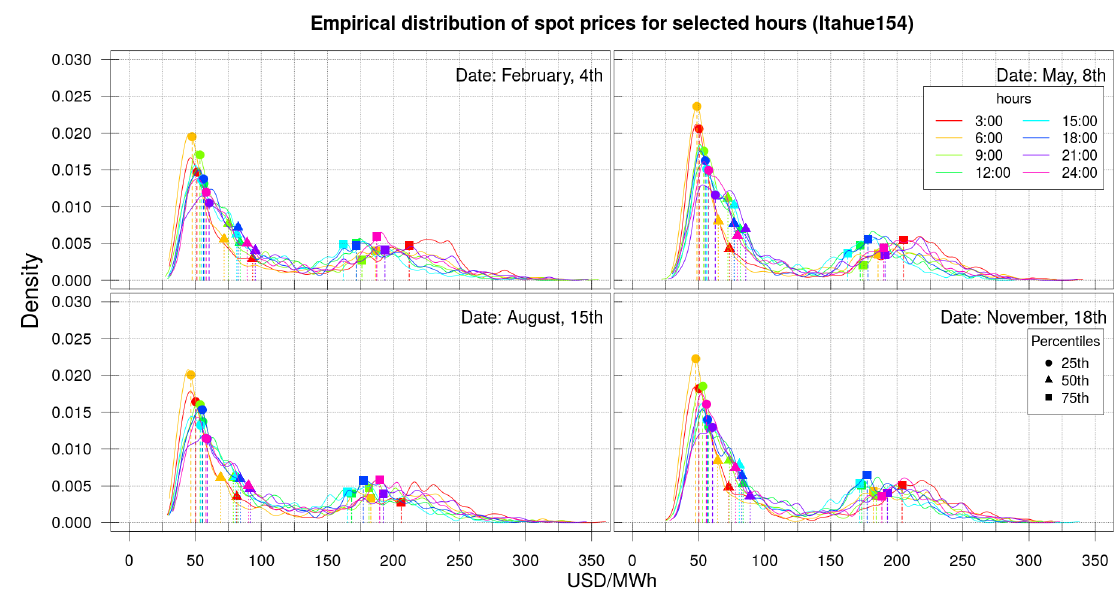
Figure 6. Empirical density distribution spot prices for Itahue154 in four representative days of the